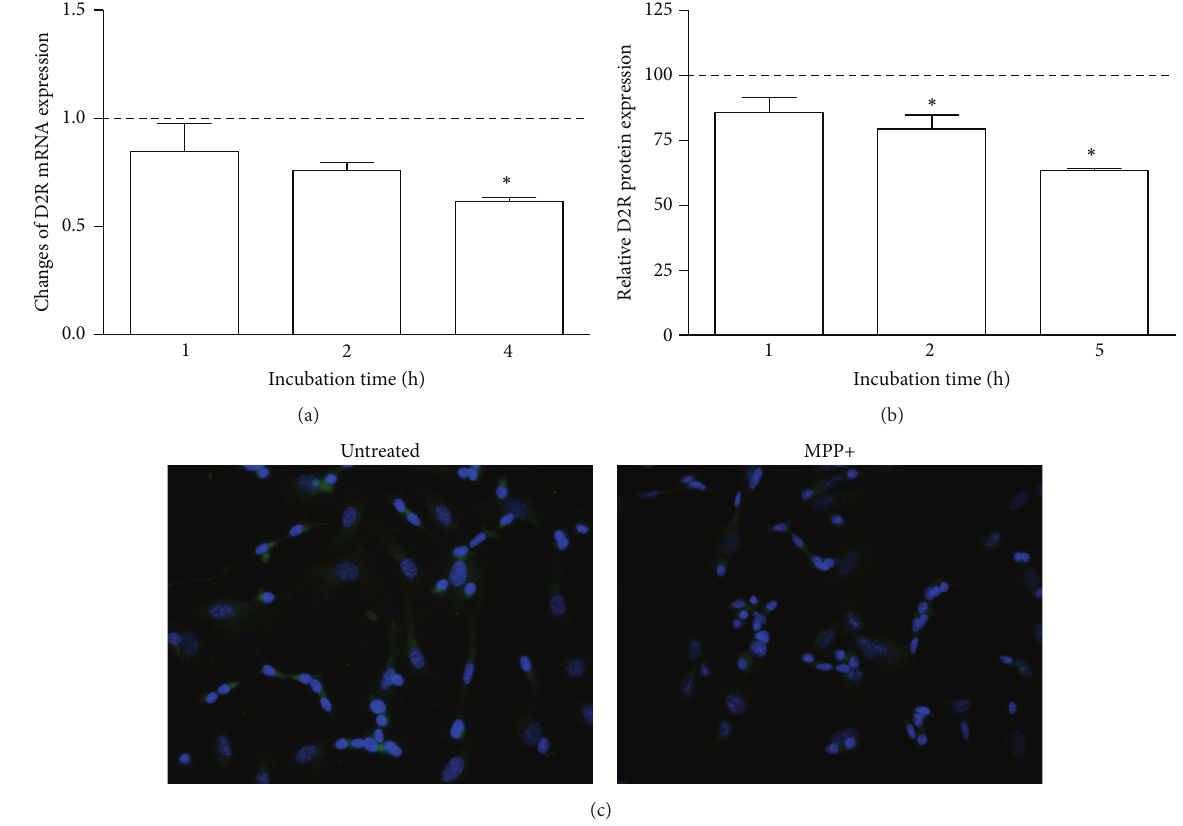
Figure 5: The effect of MPP+ on D2R expression in differentiated SK-N-SH cells. Confluent cells were incubated with MPP+ at different time intervals. D2R mRNA expression was analyzed by Real-Time PCR (a). The figure represents changes of mRNA expression after different times of incubation in comparison to untreated cells assumed to possess value equal to 1 (dashed line). The expression of D2R protein was analyzed by immunocytochemistry with specific antibodies and the quantification of the fluorescence signal was performed as described in Materials and Methods (b). The results are shown as mean ± SD of the changes in comparison to untreated cells, assumed to show 100% expression (dashed line). (c) The photographs show D2R expression by differentiated SK-N-SH cells without or after 5-hour incubation with MPP+. ∗ 𝑃 < 0.05 versus untreated